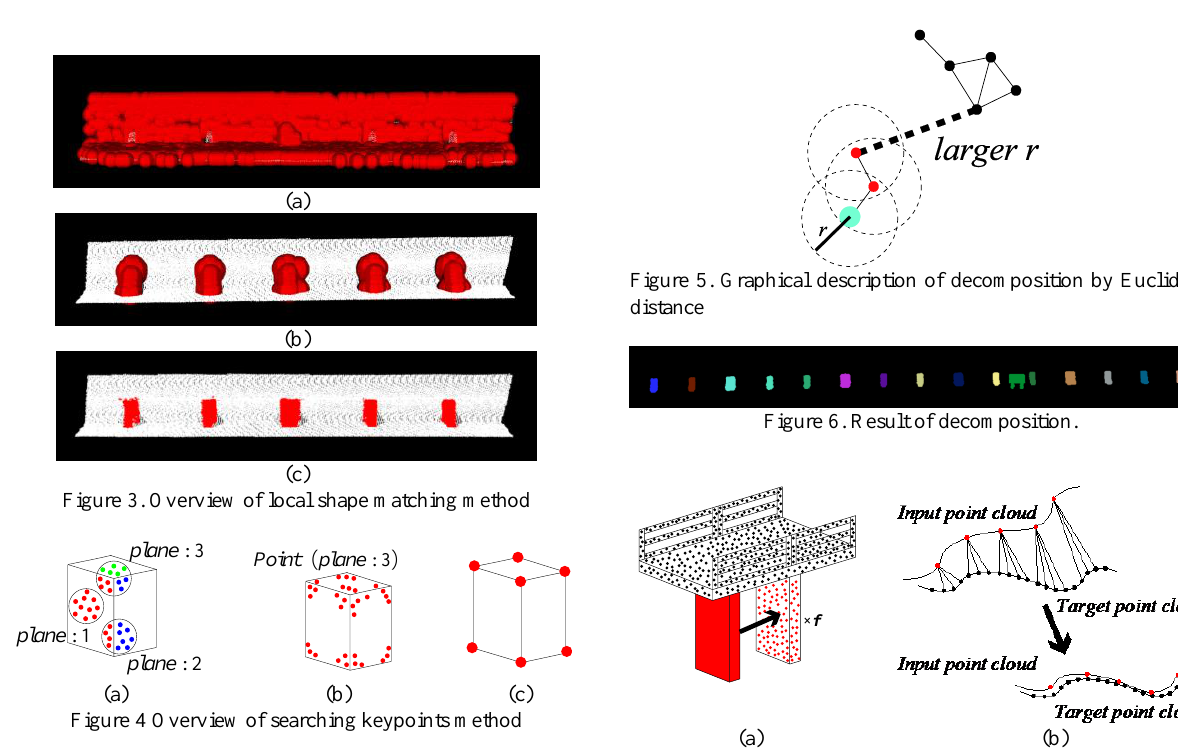
Figure 7. Graphical description of ICP